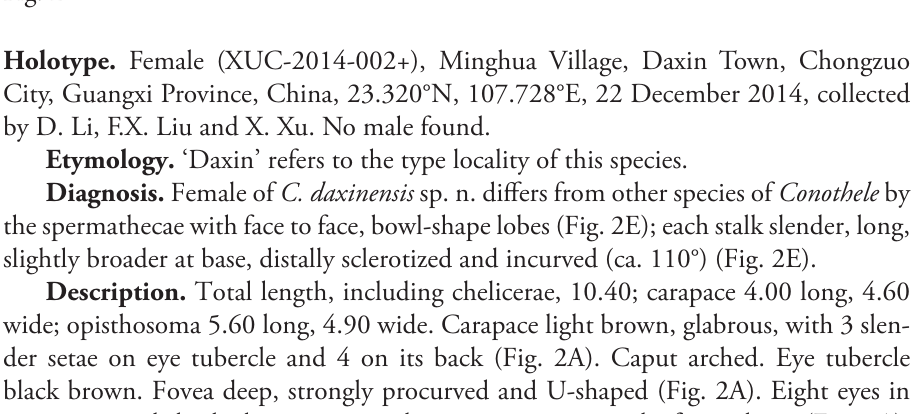
Holotype. Female (XUC-2014-002+), Minghua Village, Daxin Town, Chongzuo City, Guangxi Province, China, 23.320°N, 107.728°E, 22 December 2014, collected by D. Li, F.X. Liu and X. Xu. No male found.